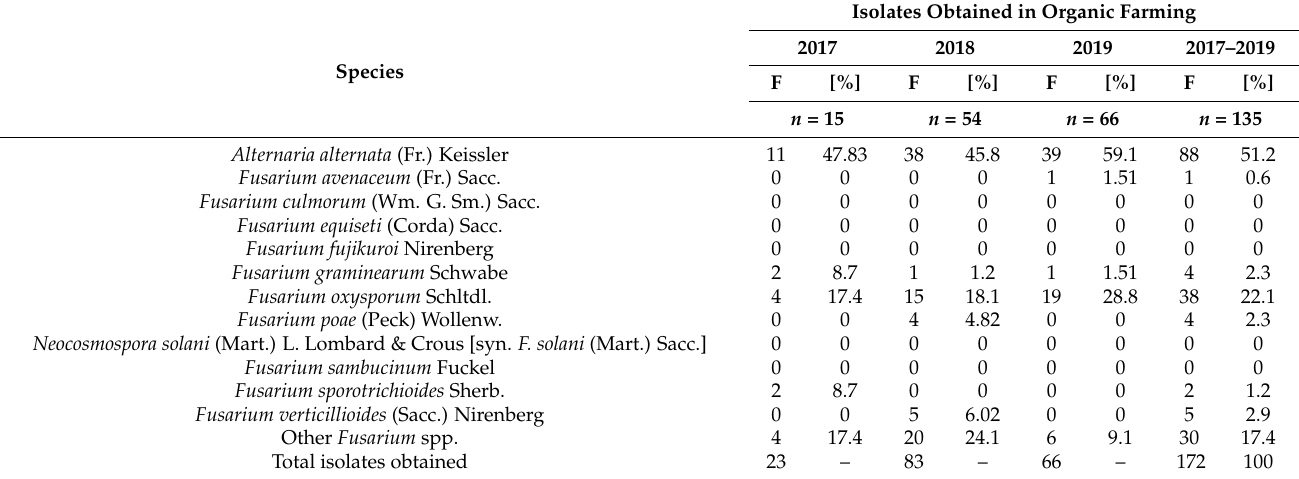
Isolates Obtained in Organic Farming